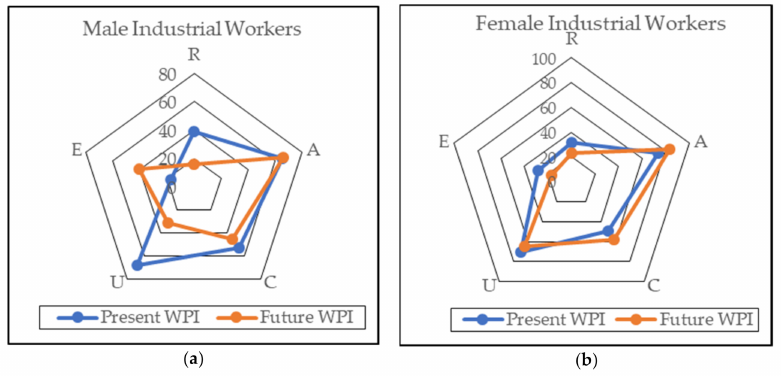
Figure 8. Present and future WPI pentagrams for ( a ) male industrial workers and ( b ) female industrial workers in the Tetuljhora union.